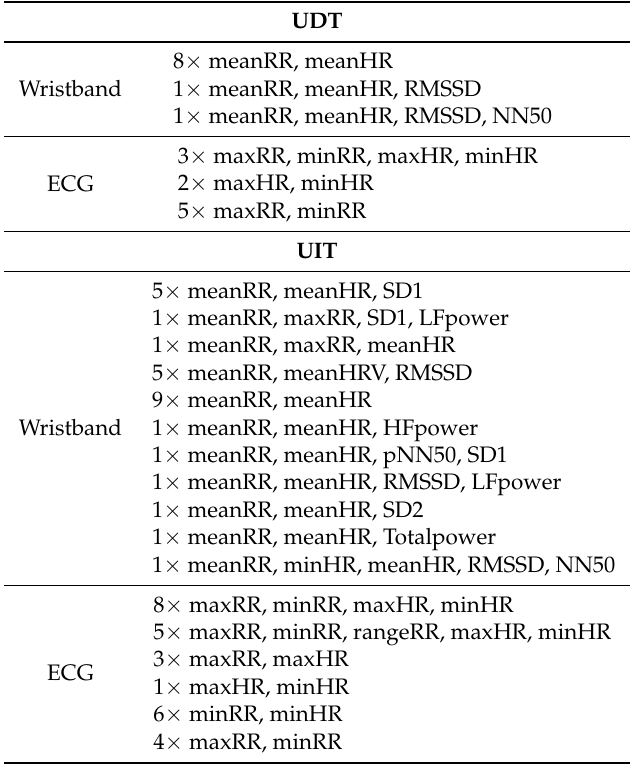
Table 5. Selected Feature Subsets in CFSS for User-Dependent Test (UDT) (10 iterations in 10-fold Cross Validation (CV)) and User-Independent Test (UIT) (27 iterations in LOSOCV) with number of occurrences for wristband and ECG. UDT 8 × meanRR, meanHR 1 × meanRR, meanHR, Wristband